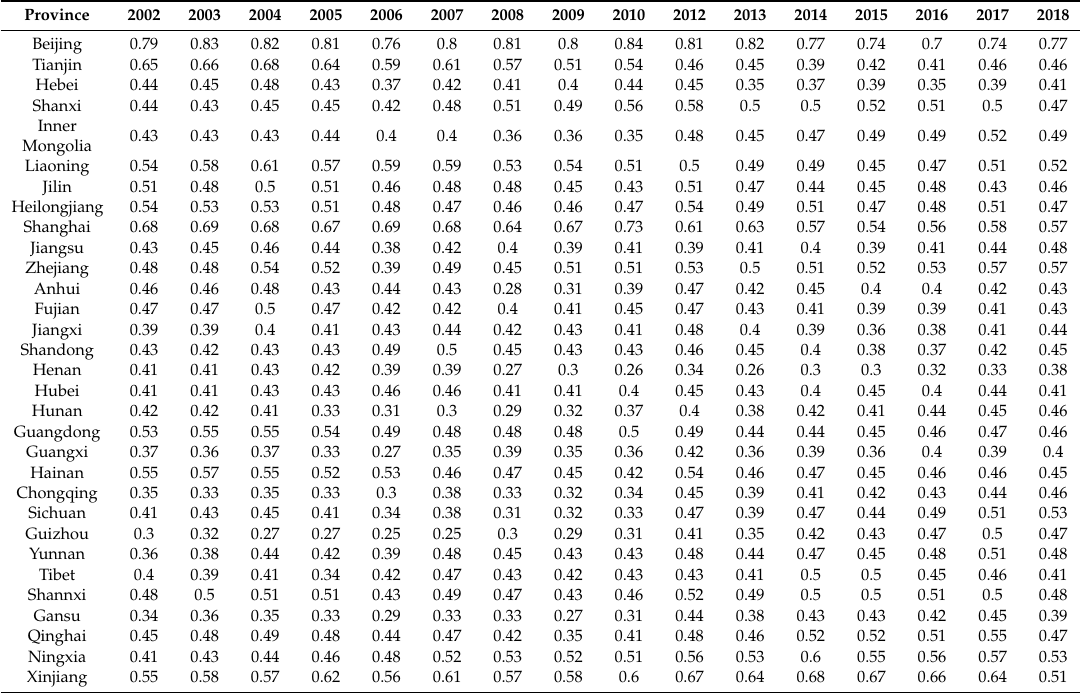
Table 3. The health indices of Chinese